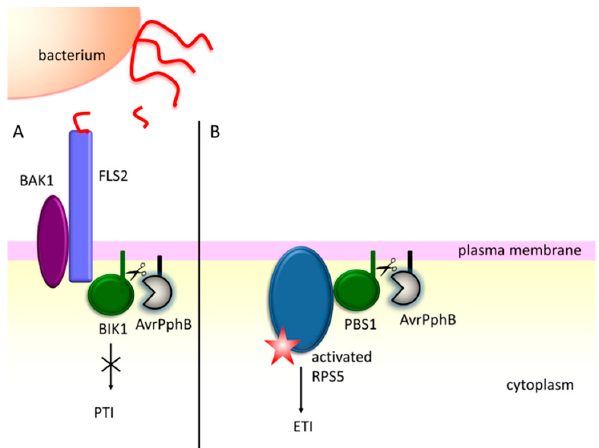
Figure 3. The AvrPphB effector protease from P. syringae acts as a double sword in the plant response to bacterial infection. ( A ) After the recognition of flagellin by FLS2, AvrPphB degrades the botrytis-induced kinase 1 (BIK1) of the active receptor complex and blocks the pattern-triggered immunity (PTI) pathway [130,131]. ( B ) Alternatively, AvrPphB may cut the PBS1 protein, which is guarded by the RPS5 (resistance to Pseudomonas syringae 5) protein. RPS5 becomes activated and induces the effector-triggered immunity (ETI) response [134].